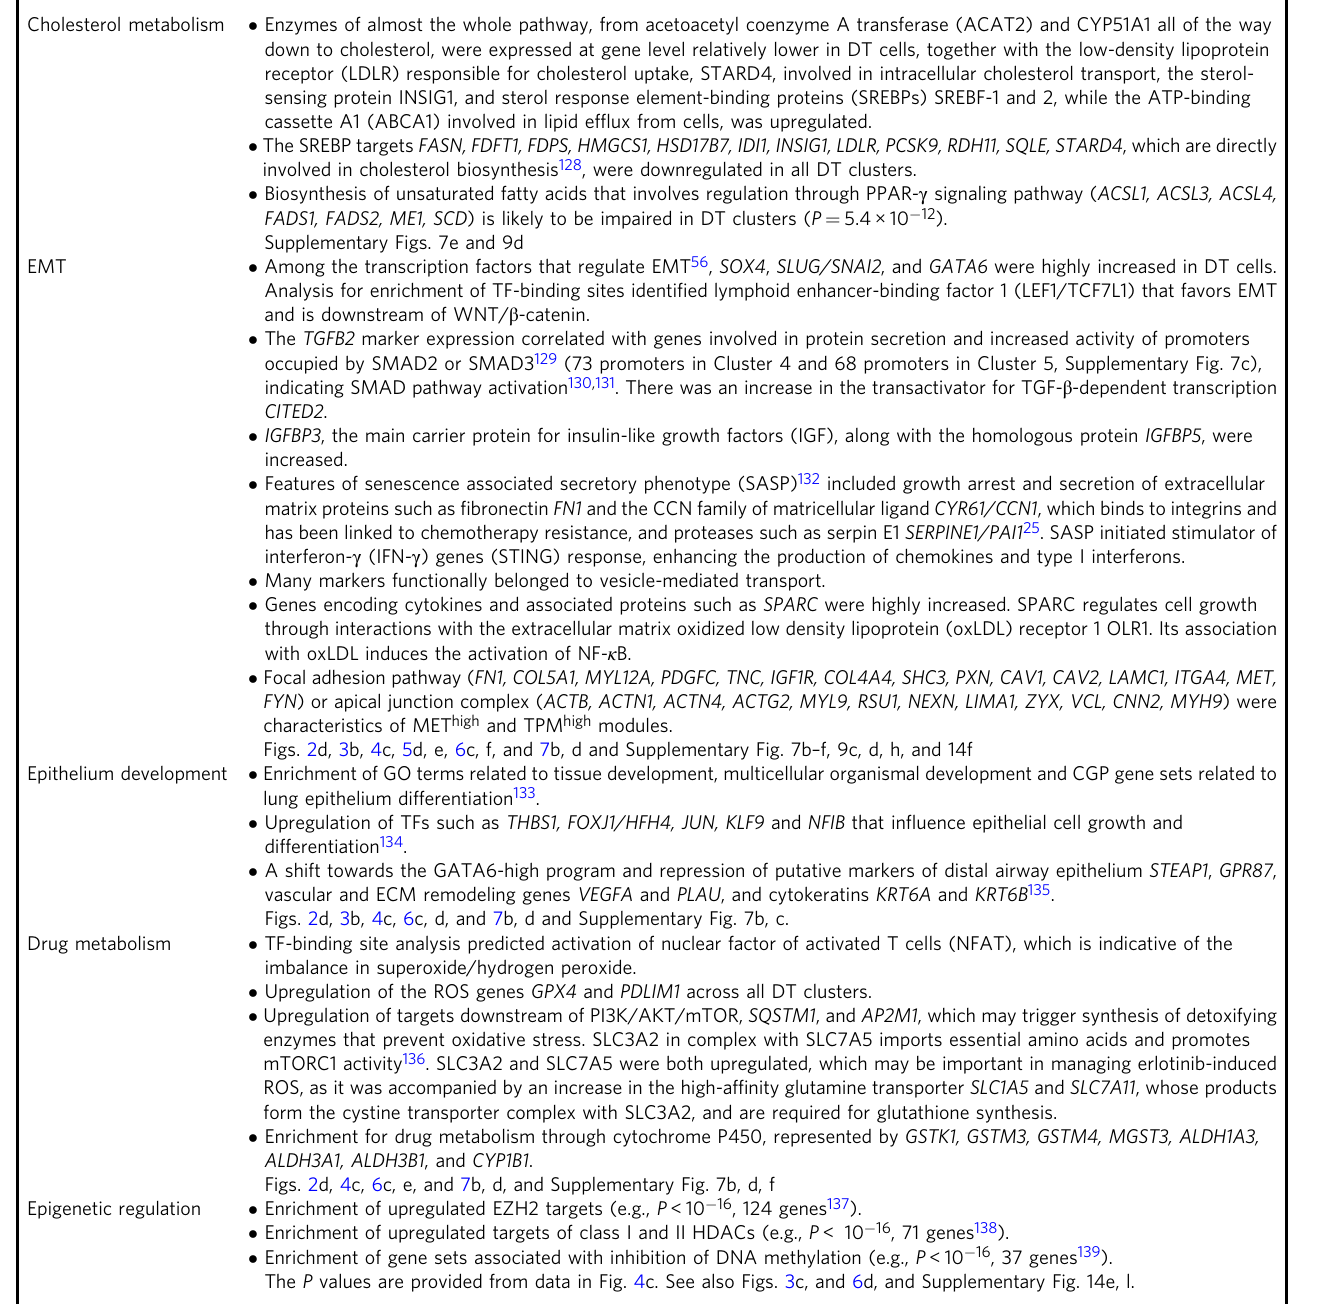
Table 1 Hallmarks of erlotinib resistance in EGFR-mutant cell